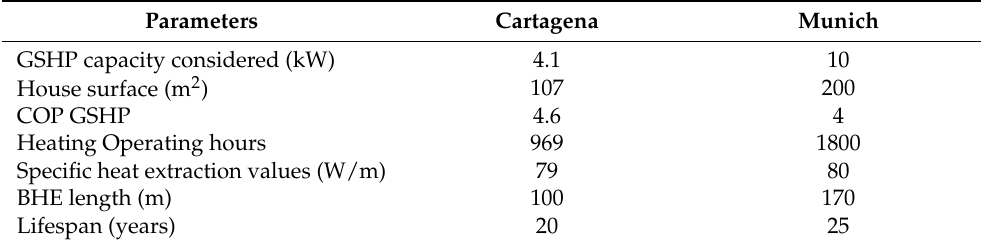
Table 3. Assumed site-specific conditions and technical details for the base case and the case devel- oped in Cartagena for the Life Cycle Analysis